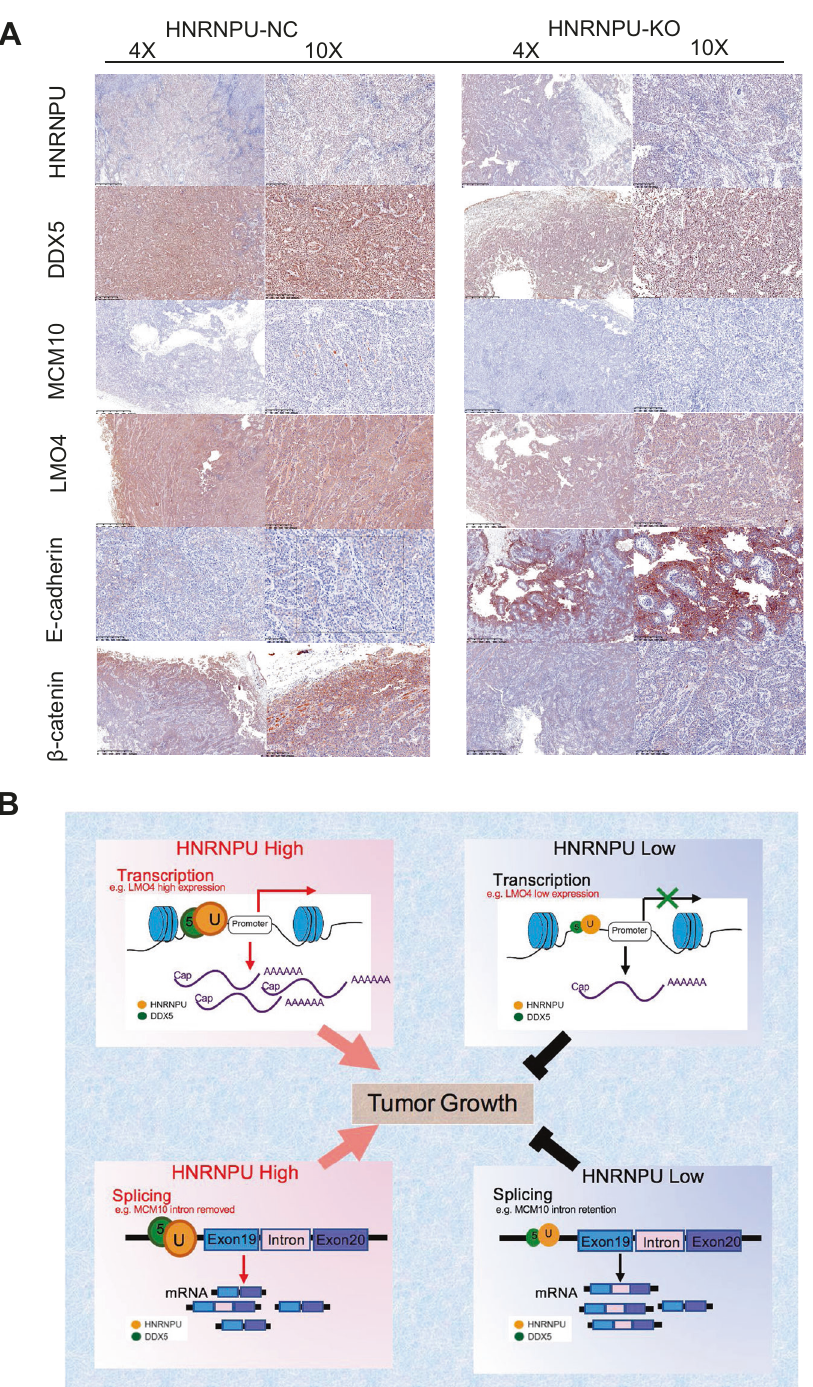
Fig. 7 The HNRNPU-DDX5 complex is related to poor breast cancer prognosis, and the underlying molecular mechanism model was clari fi ed. A Representative images of immunohistochemical staining as indicated in the xenografted tumours. B The proposed working model of this RNA-seq analysis HNRNPU knockout and DDX5 knockdown cells, as well as normal controls, were collected, and total RNA was extracted using TRIzol Reagent (Invitrogen) according to the instructions. The quality of RNA was evaluated by an Agilent 2100 Bioanalyzer (Agilent Technologies, Palo Alto, CA, USA), and samples with an RNA integrity number (RIN) value above 9 were suitable for cDNA library construction. RNA-Seq libraries generated from the MCM10 CA1a and MCF10 DCIS cell lines (with duplicates for each sample